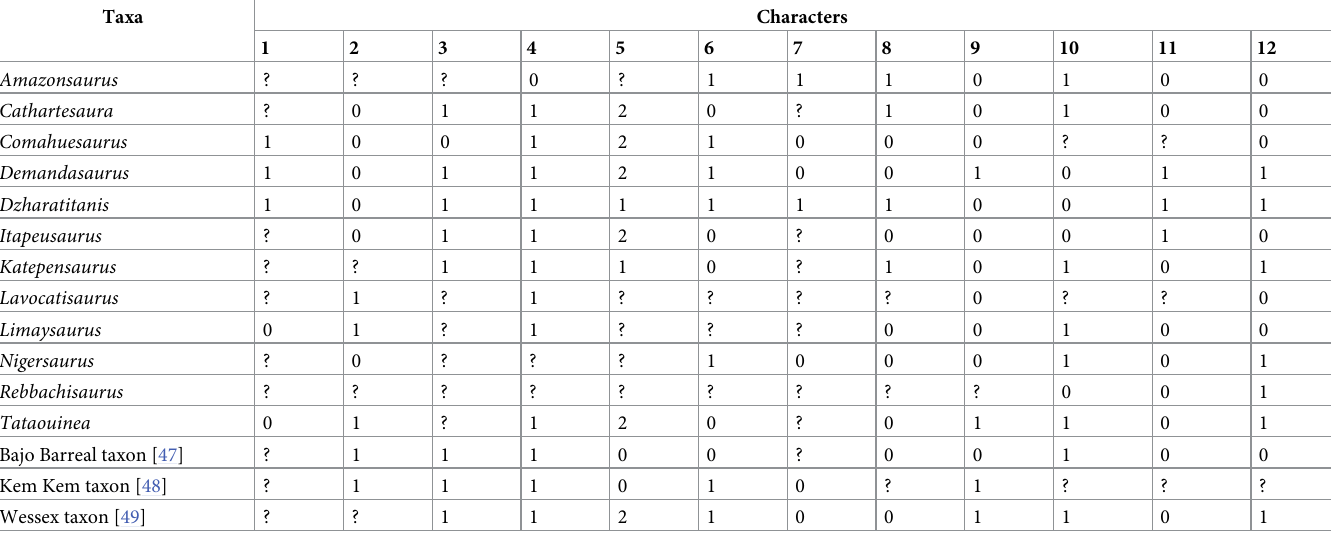
Table 2. Distribution of the diagnostic characters of anterior caudal vertebrae in the Rebbachisauridae.